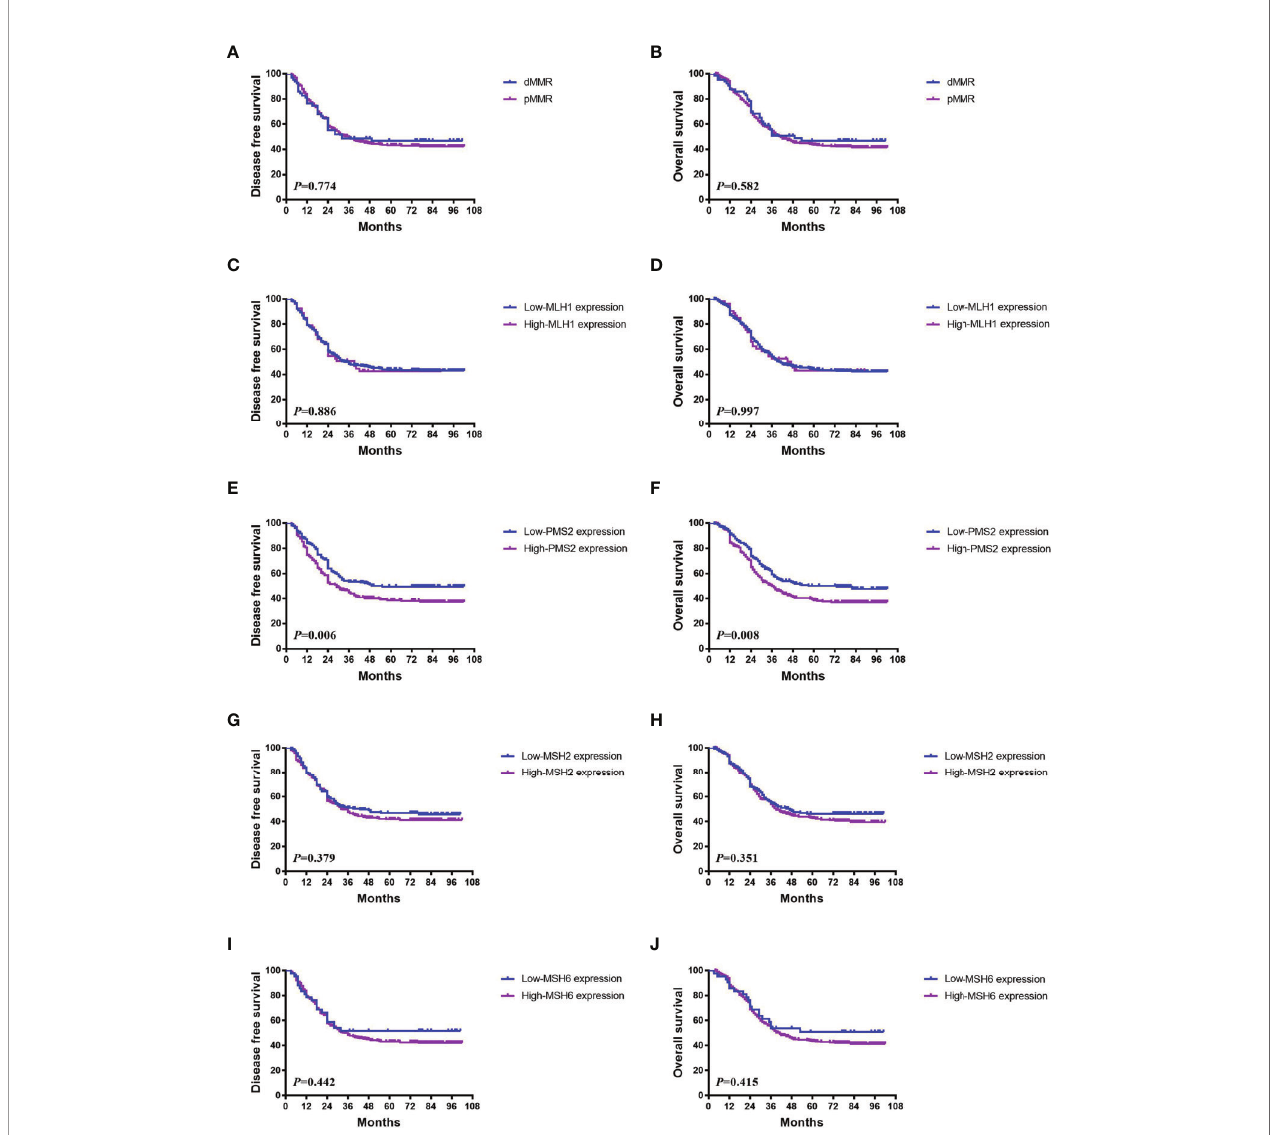
FIGURE 2 | Association between MMR status and survival in ESCC. (A, B) There was no signi fi cant survival difference between pMMR and dMMR patients ( P >0.05). (C, D) No differences in DFS ( P = 0.886) and OS ( P = 0.997) were found between patients with low MLH1 expression and high expression. (E, F) 224 patients with low PMS2 expression had better DFS and OS than 260 patients with high PMS2 expression ( P = 0.006 for DFS and 0.008 for OS). (G – J) Similar tendencies were also observed in those with low MSH2 expression ( P = 0.379 for DFS and 0.351 for OS), and low MSH6 expression ( P = 0.442 for DFS and 0.415 for OS).